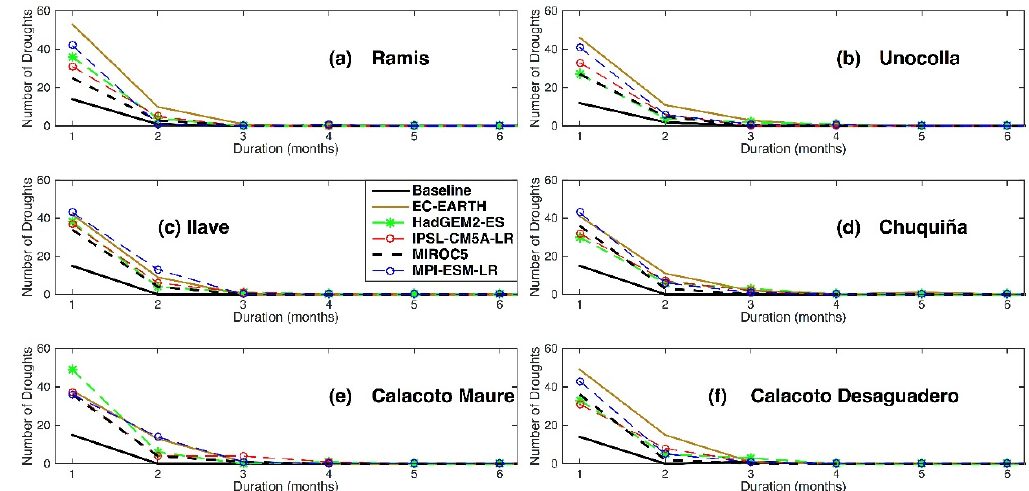
Figure 9. Frequency of meteorological droughts according to their duration. Results for baseline and futures scenarios defined by five selected global circulation models (GCM) are shown for six sub-basins controlled at the following stations: ( a ) Ramis (1), ( b ) Unocolla (2), ( c ) Ilave (3), in Peru, and ( d ) Chuquiña (7), ( e ) Calacoto Maure (6), ( f ) Calacoto Desaguadero (5), in Bolivia. Numbers in parentheses indicate the location of control points in Figure 1b.